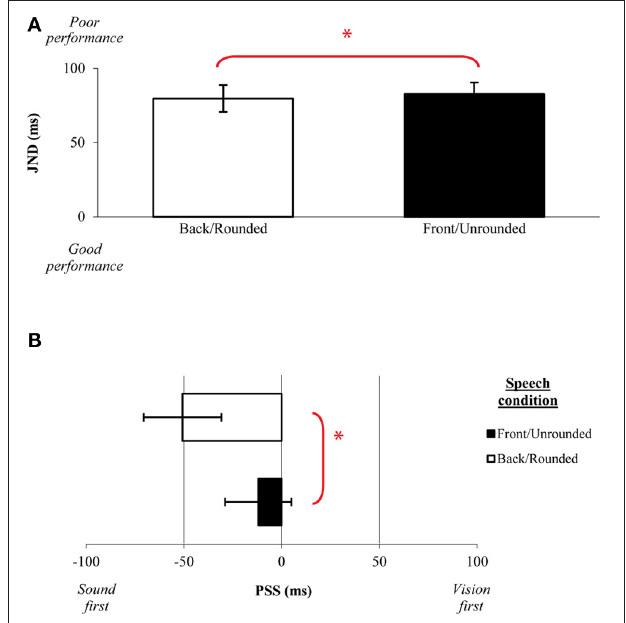
FIGURE 8 | Average (A) JNDs and (B) PSSs for the backness/roundedness of the vowel stimuli presented in Experiment 3. The error bars represent the standard errors of the mean. Asterisks indicate significant differences between the various stimuli